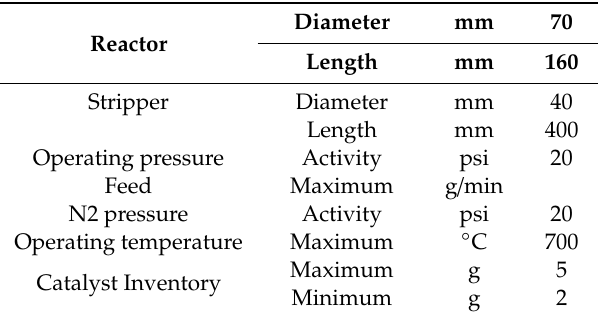
Table 16. TCE Specifications of Design.